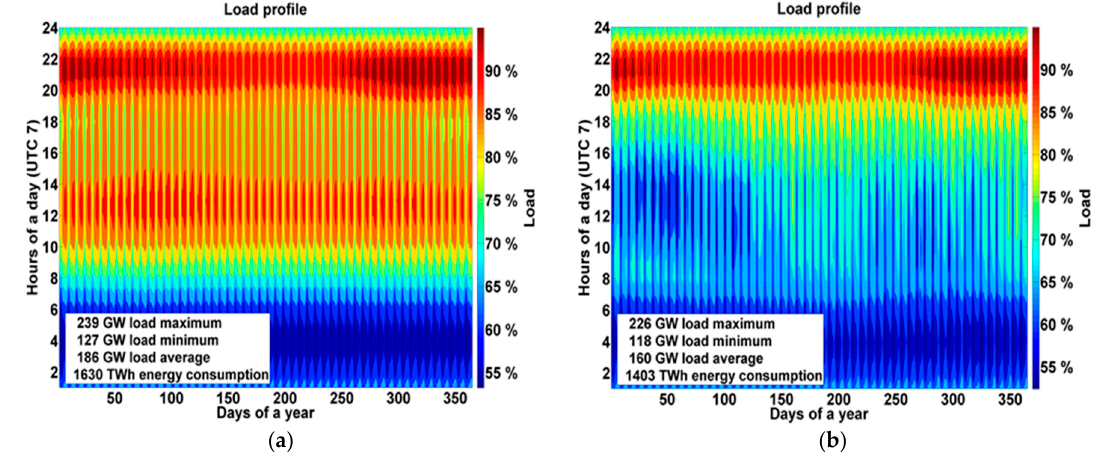
Figure 5. ( a ) Aggregated load curve; and ( b ) load curve with PV prosumers influence for Southeast Asia for the year 2030.